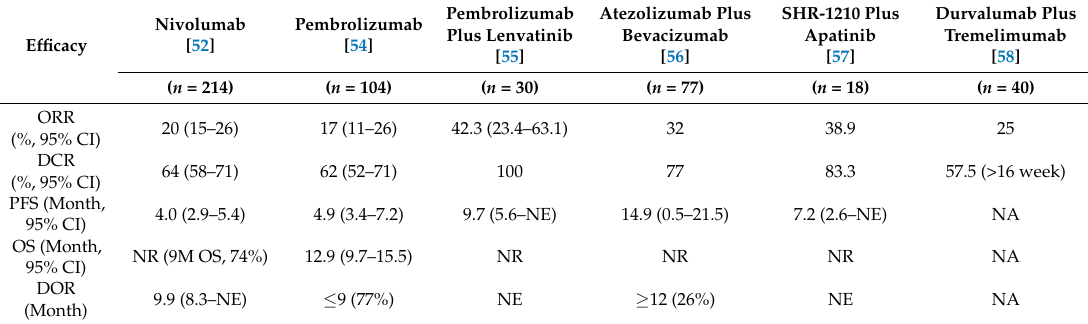
Table 5. Results of immune checkpoint inhibitors and combination